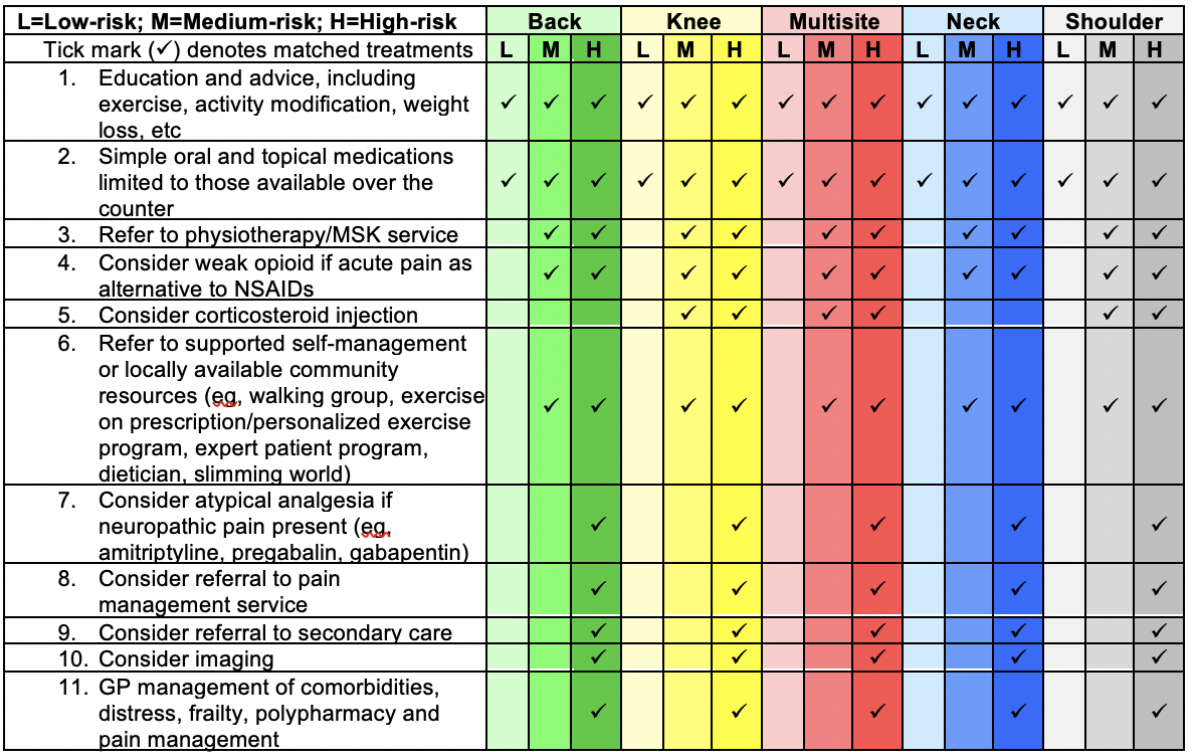
Figure 3. Recommended matched treatment options. GP: general practice; MSK: musculoskeletal; NSAIDS: Nonsteroidal anti-inflammatory drugs.